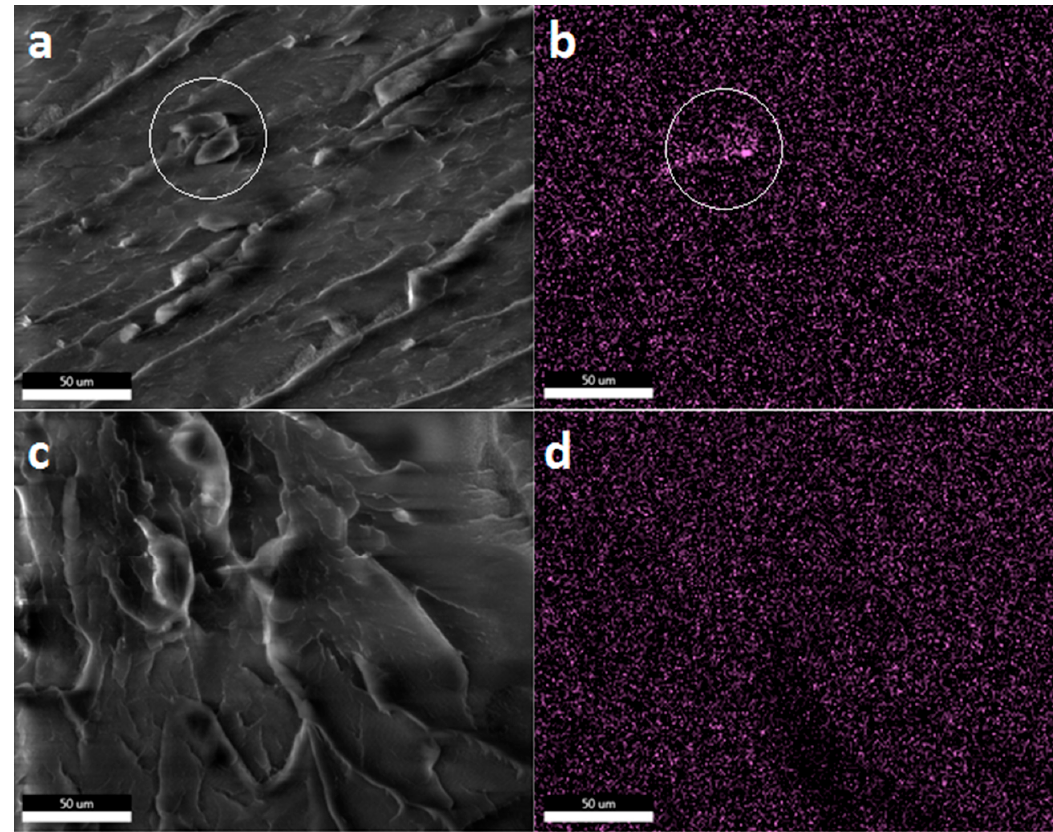
Figure 3. SEM images ( left ) and EDS maps of silicon ( right ) of 1% i Bu 7 SSQ-3OH/PE composite obtained by extrusion ( a , b ) and injection moulding ( c , d ).